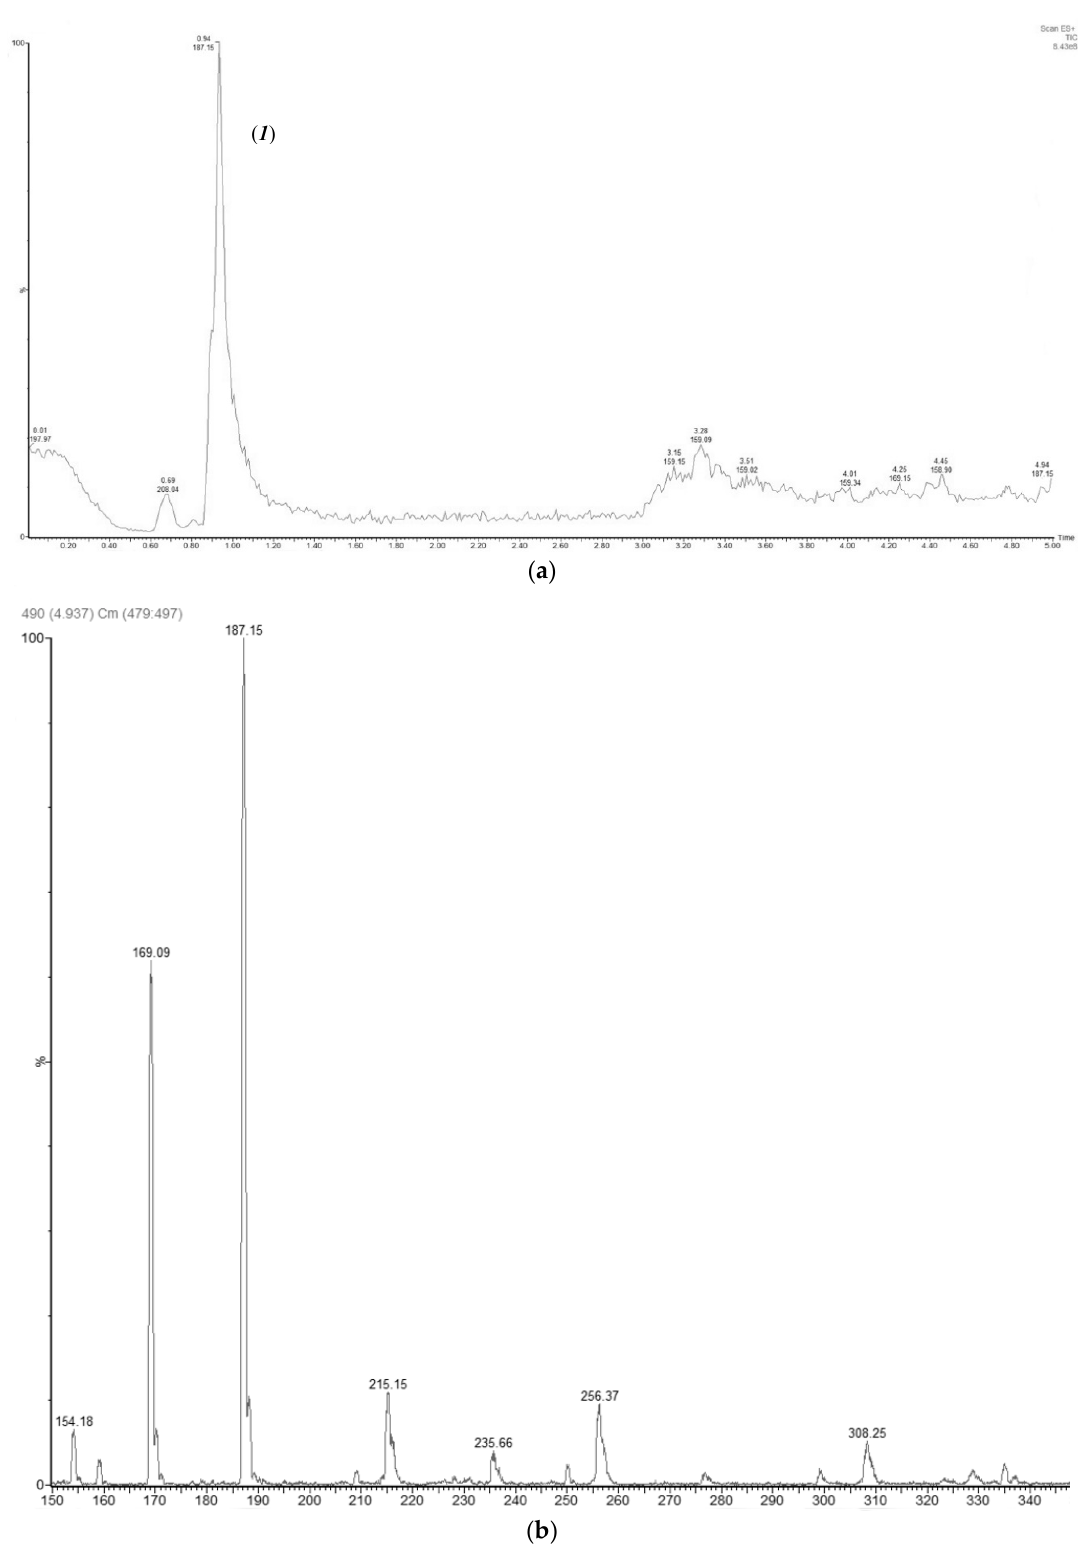
Figure 3. uHPLC/MS analyses of lipase-catalyzed esterification of sorbic acid and glycerol by immobilized CALB in solventless media; ( a ) uHPLC chromatogram, showing the peak of glycerol sorbate (peak No 1) at 0.94 min; ( b ) ESI+/MS spectrum of the peak No 1, showing the ester product by electro spray ionization mass spectroscopy.